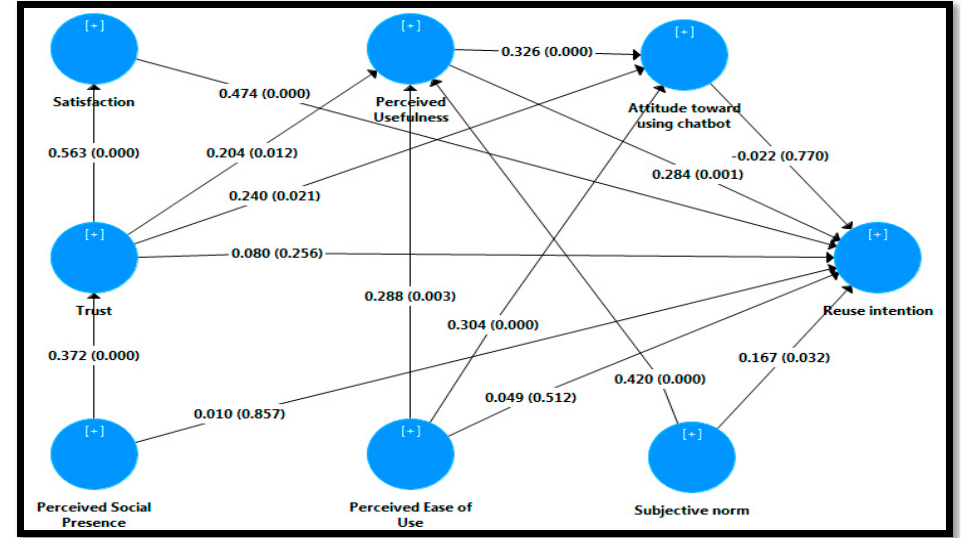
Figure 2. The structural model. Table 4. Path Estimates for Proposed Model.